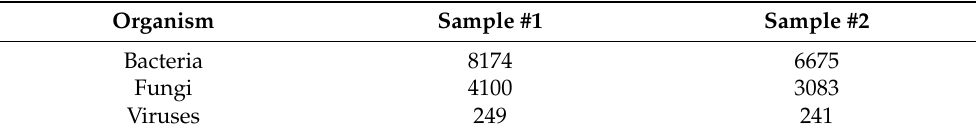
Table 1. Resulting contigs identified using BLASTn.